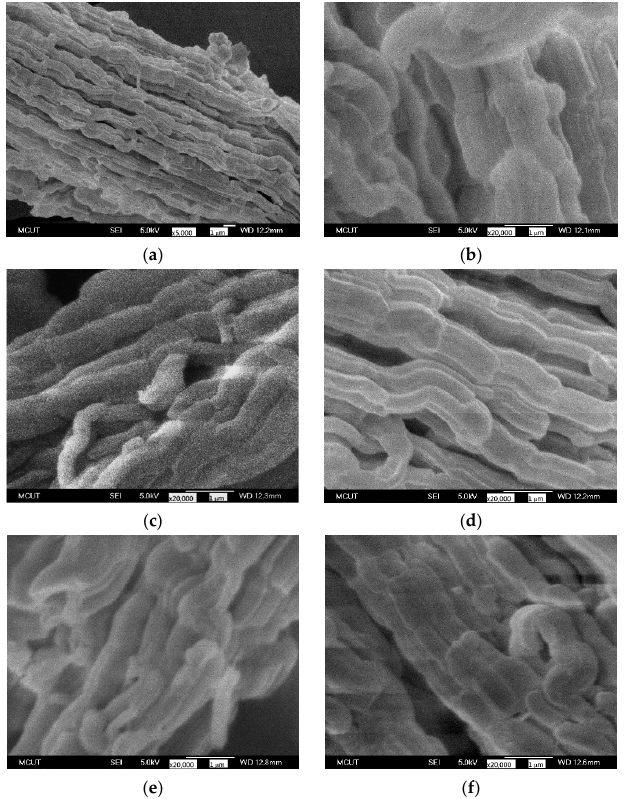
Figure 6. SEM images: ( a ) SBA ‐ 15; ( b ‐ d ) SBA ‐ 15 synthesized at hydrothermal treatment times of 12, 24, and 72 h, respectively; ( e ) SBA ‐ 15/APTES; ( f ) SBA ‐ 15/PEHA.